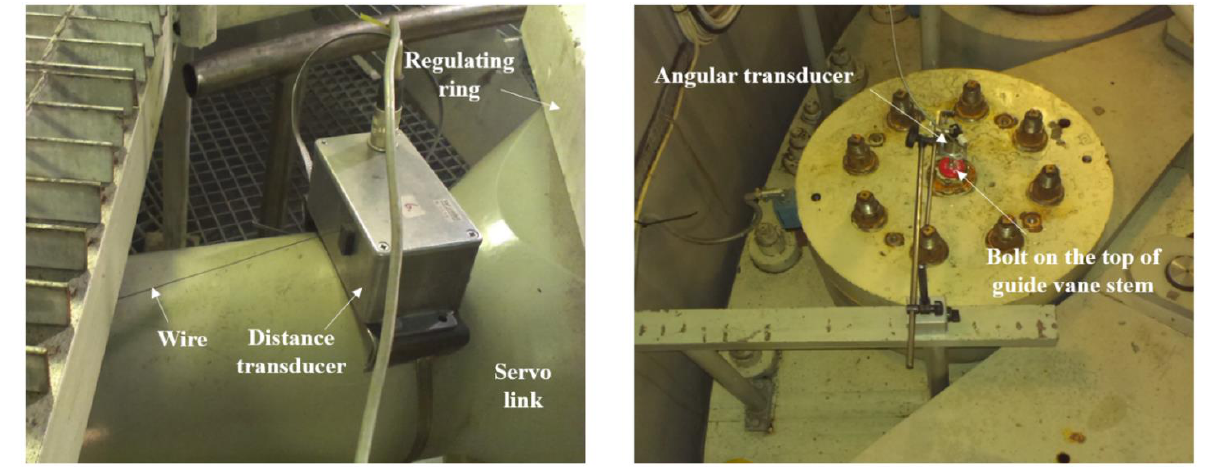
Figure 5. Part of measurements for this paper: measuring device for turbine actuator movement. The left figure shows the distance transducer of wire type, which measures position of servo link; the right figure demonstrates the angular transducer which measures guide vane opening.